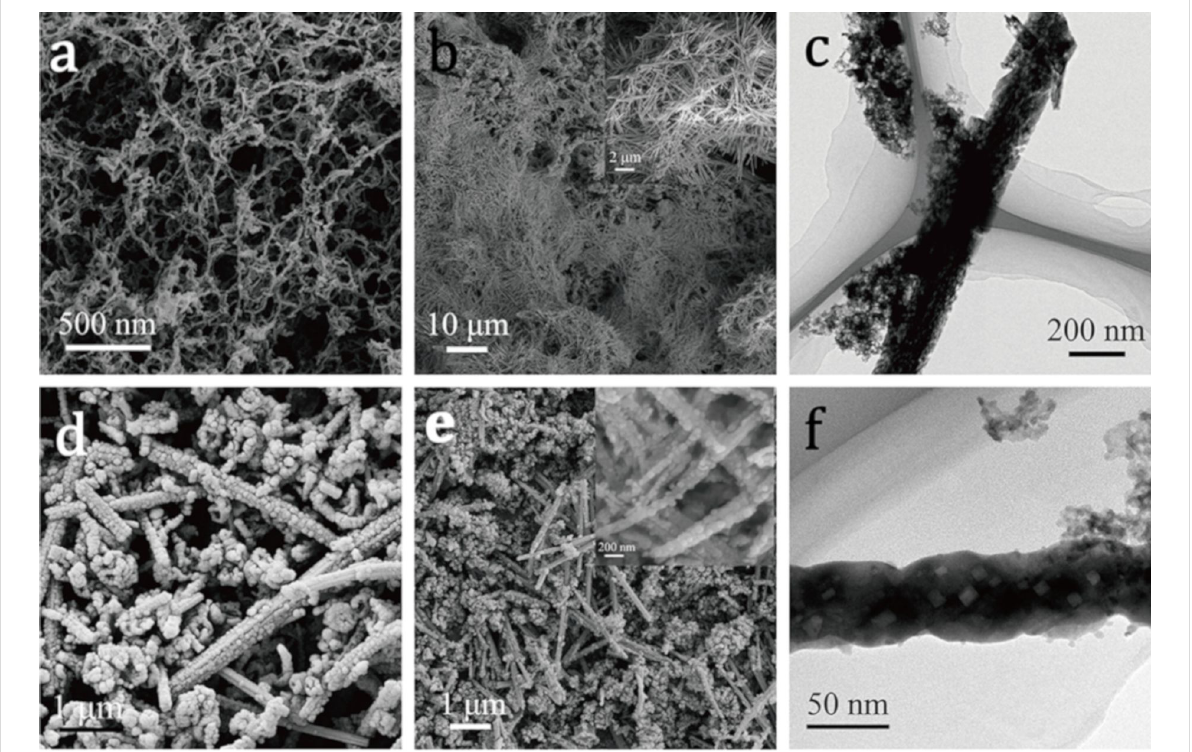
Figure 2: (a) SEM image of CA; (b) SEM and (c) TEM images of NiMoO 4 /CA; (d) SEM image of NiMoO 4 @ZIF-67/CA; (e) SEM and (f) TEM images of NiMoO 4 @Co 3 O 4 /CA.